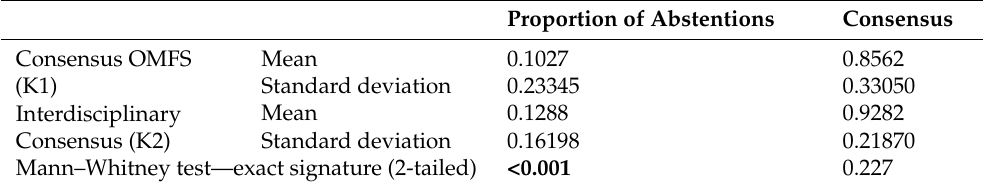
Table 5. Proportion of abstentions and consensus (significant results are highlighted by bold charac- ters).